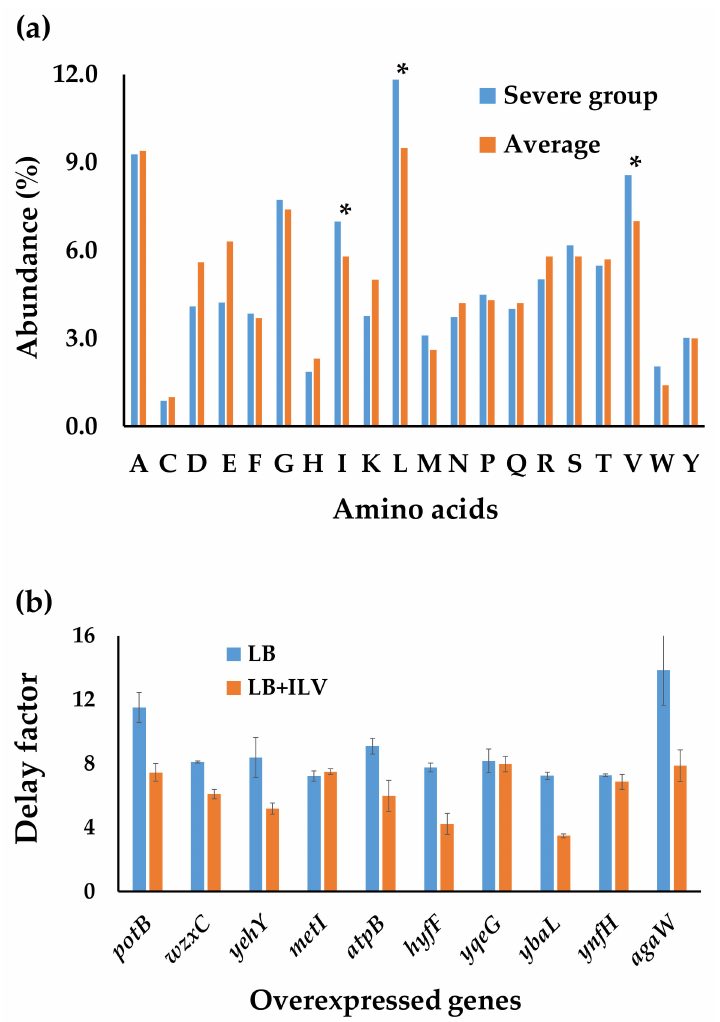
Figure 3. The effects of amino acid compositions on cell growth. ( a ) The abundance of each amino acids in proteins with severe growth effects. One-letter abbreviations of amino acids were used. The t -test was used and significant differences ( p < 0.05) were marked with *. ( b ) The delay factors of selected strains grown in media with or without supplementary branched-chain amino acids (BCAAs). The abundances of ILV in the selected genes are potB (37.46%), wzxC (36.19%), yehY (35.58%), metI (35.02%), atpB (34.44%), hyfF (33.64%), yqeG (33.25%), ybaL (33.16%), ynfH (33.10%), and agaW (33.08%). The delay factor was defined as the ratio of the doubling time of individual strains in the ASKA collection over the doubling time of the strain harboring the no insert control of the pCA24N vector. ILV means isoleucine, leucine, and valine. The mean values and deviations were calculated from three biological